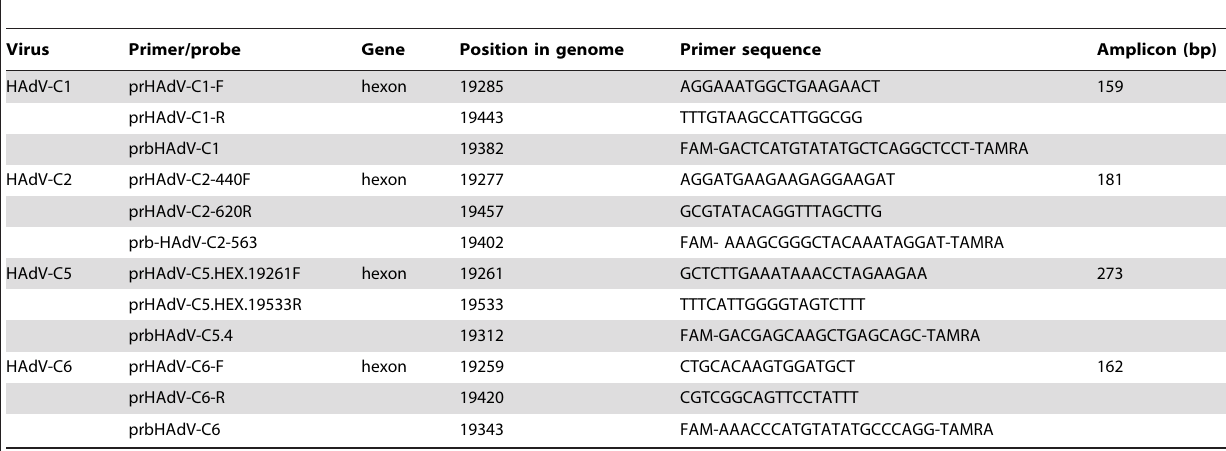
Table 4. Primers for real-time PCR amplification of adenovirus. The accession numbers for the viral genome sequences are HAdV- C1 (AF534906), HAdV-C2 (AC_000007), HAdV-C5 (AC_000008), HAdV-C6